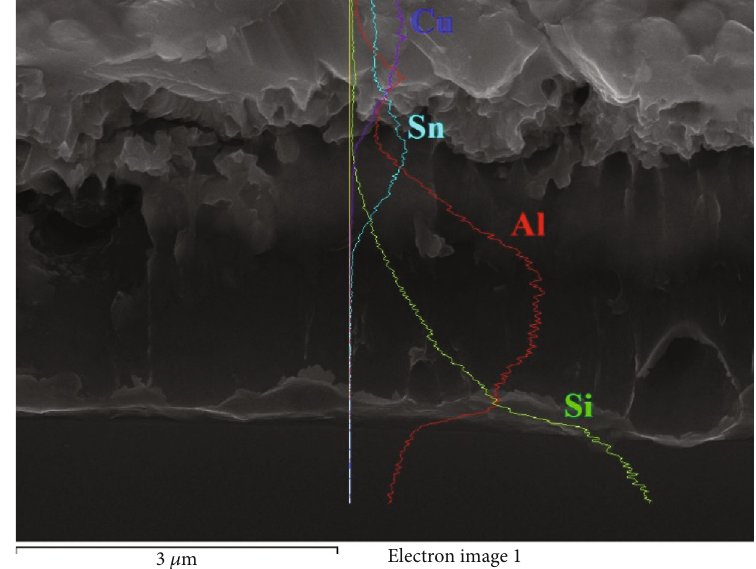
Figure 4: SEM and EDX for the upper part of the metal-faced layer of a photovoltaic solar